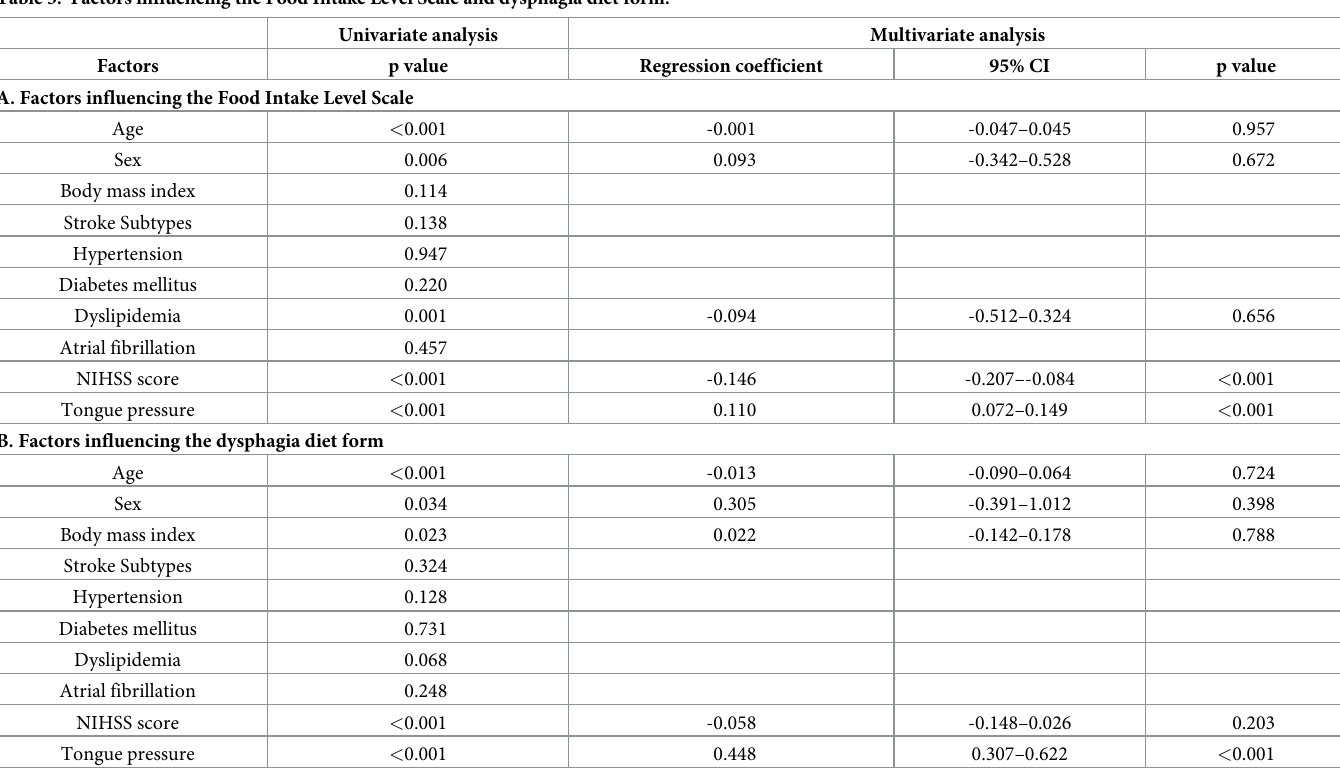
Table 3. Factors influencing the Food Intake Level Scale and dysphagia diet